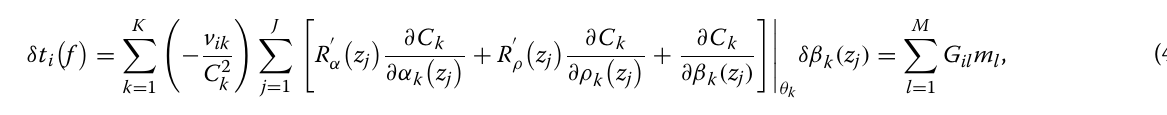
tion; Fig. 4). To account for the influence of